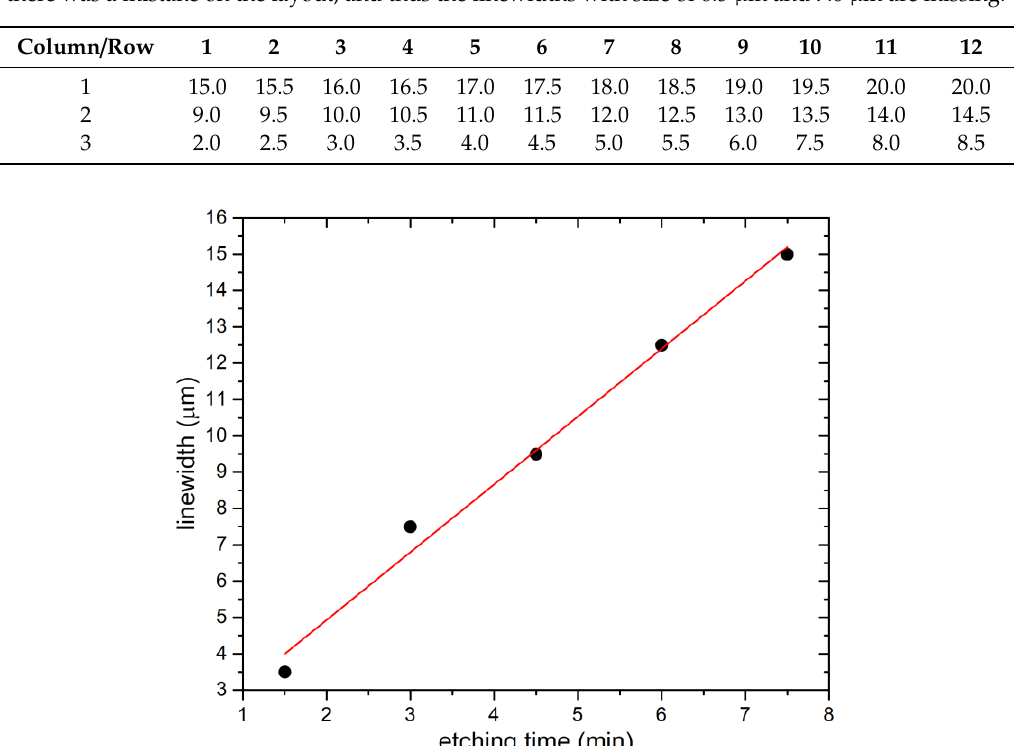
Figure 2. SiO 2 etching as function of time. The curve was obtained as linear approximation for six etched samples for different time in range from ≈1.5 min to ≈7.5 min with an interval of ≈1.5 min.